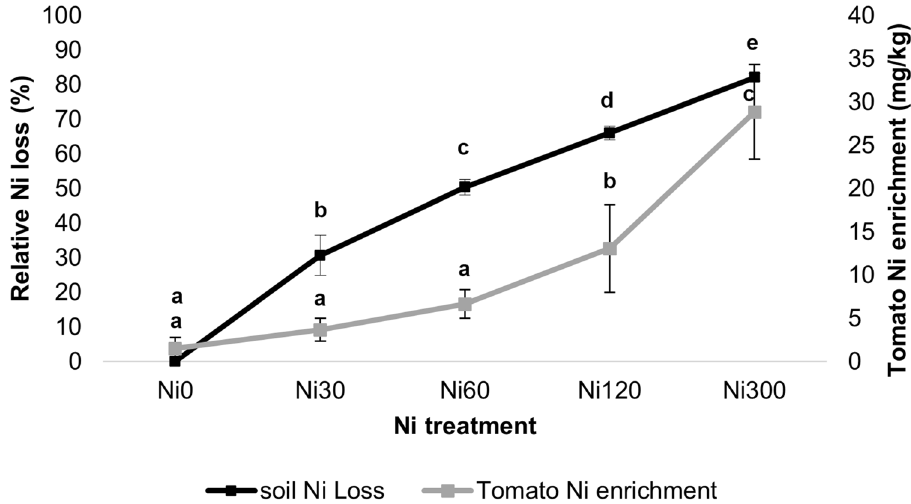
Figure 1. Relative Ni loss from soil (%) and Ni enrichment in tomato fruit (mg kg −1 DW), n = 10, each treatment. Data are average ± SD. Effective hypothesis decomposition, vertical bars denote 0.95 confidence intervals. Significant differences (obtained with Tukey’s post-hoc test) are marked with